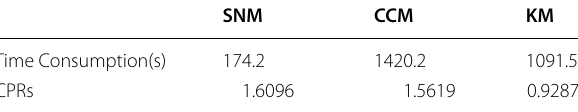
Table 3 The time consumption and CPRs of different methods for simulation signals